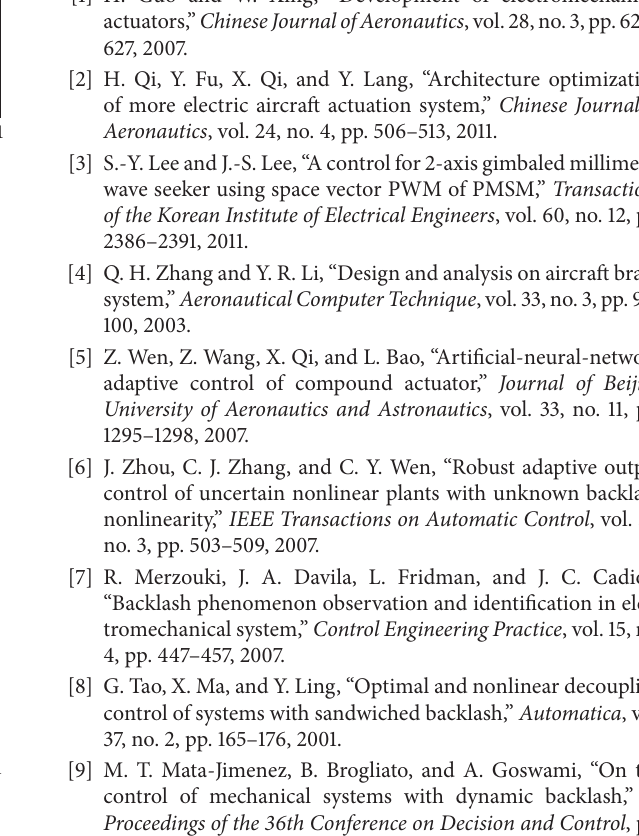
Figure 11: The tracking error under